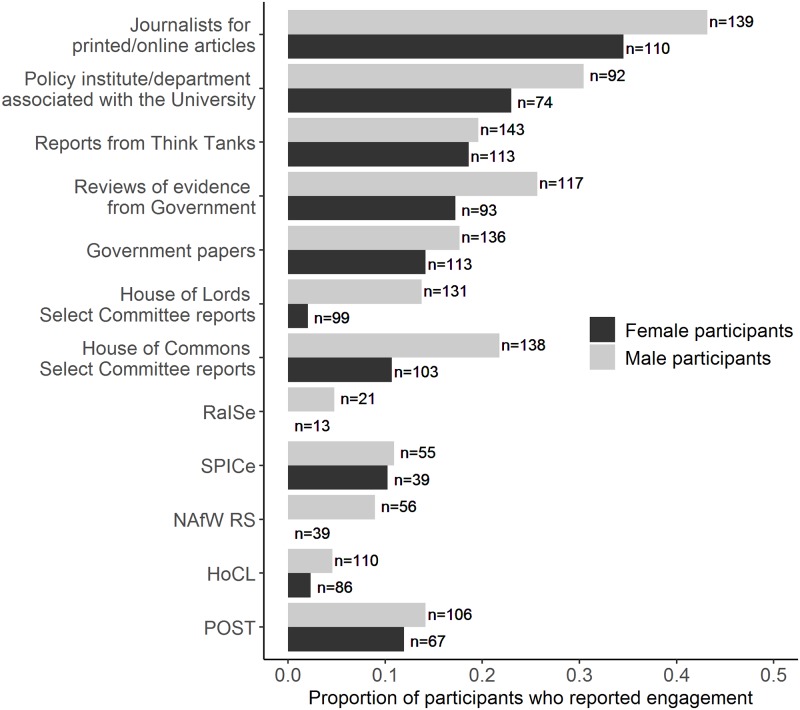
The proportion of participants that reported previous engagement that had at least heard of the option while also providing gender information.Number of individual respondents who had at least heard of the option per gender indicated on the graph. Male participants were significantly more likely to report engagement. Abbreviations: RaISe, Northern Ireland Assembly Research and Information Service; SPICe, Scottish Parliament Information Centre; NAfW, National Assembly for Wales; POST, Parliamentary Office of Science and Technology.